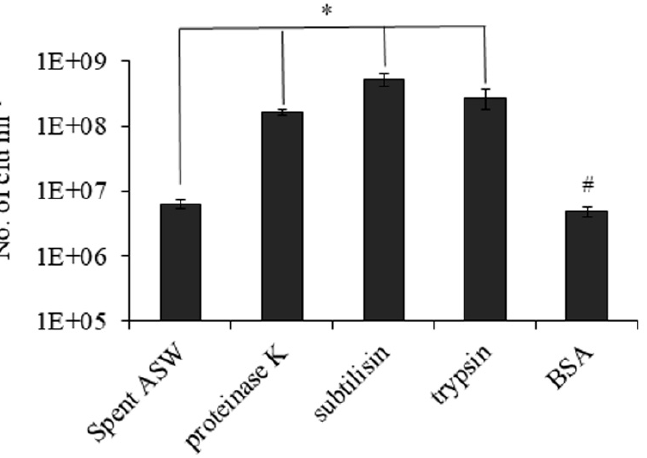
Figure 4. Effect of protease on recovery of V. cholerae from the VBNC state is a general trait. Recovery was induced in VBNC cells at 37 ° C in spent ASW media (SM) and heat-treated spent ASW media ( ∆ SM) without or with proteinase K, subtilisin, trypsin and BSA. The recovered cell count was determined after 32 h. Asterisk ( ∗ ) represents statistically significant difference in growth of VBNC cells with and without proteases in spent ASW media ( p < 0.05). # represents non-significant difference in growth of VBNC cells with and without proteases in heat-treated spent ASW media.